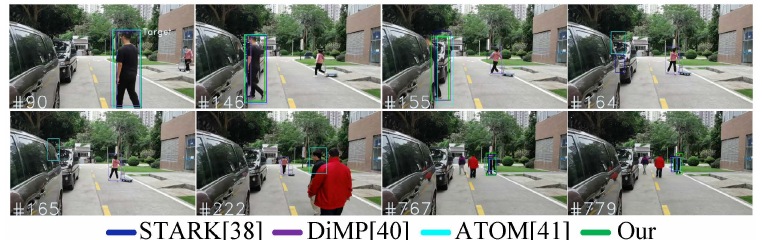
Figure 22. Person-Following Tests in Scenario#1 (seq#1), where the Target moves out of Robocar perception and faces crowding and